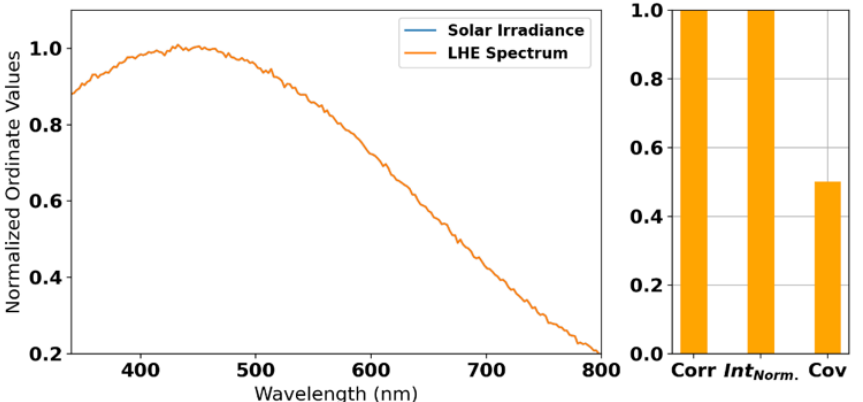
Figure A4. Proxies are shown for the AM1.5G solar irradiance spectrum and an LHE spectrum, along with the values of the correlation, integral (normalized to one) and covariance fitment conditions. Note how scaled (but not shifted) versions of the dataset affect the integral value but not the Pearson correlation. The ambiguity of “fitting” the LHE spectrum suggests that both these measures of peak-to-peak commensurability and high area-under-the-curve should be considered, which is the advantage of the covariance fitment condition. (Download the supplementary materials to review this